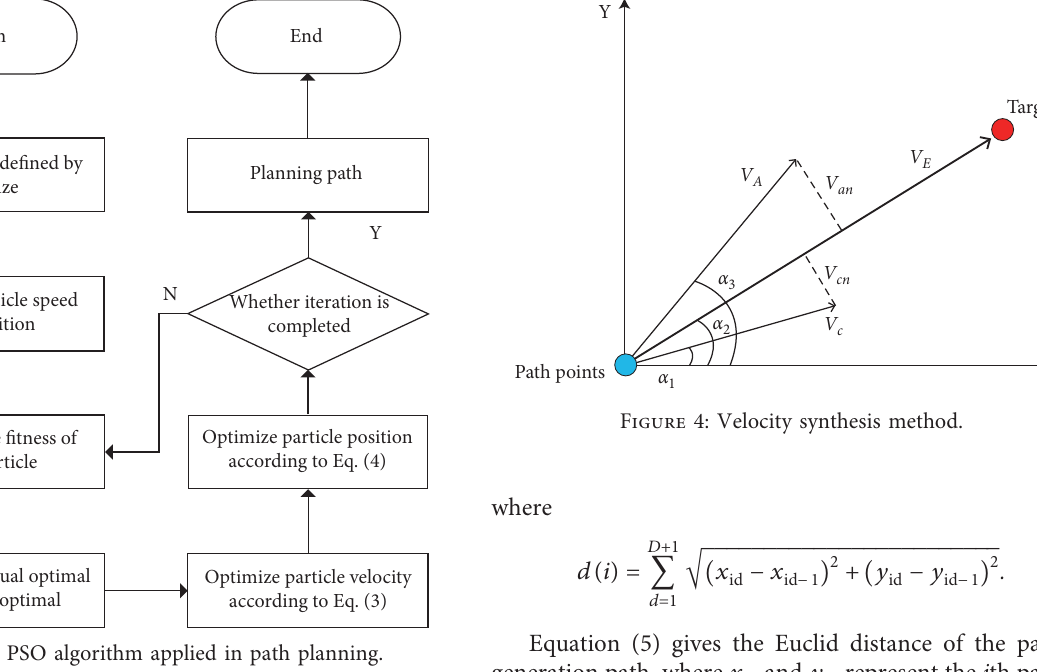
particle position according to Eq.